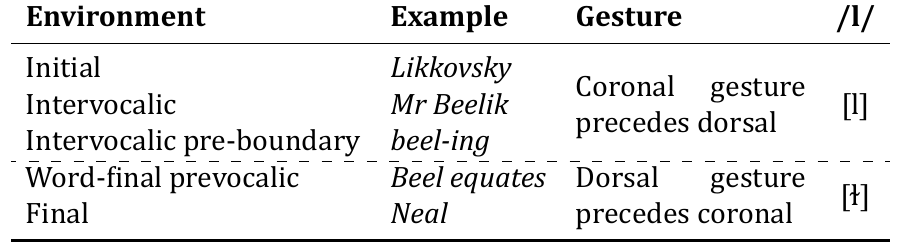
Table 6: Adapted from the results of Sproat & Fujimura